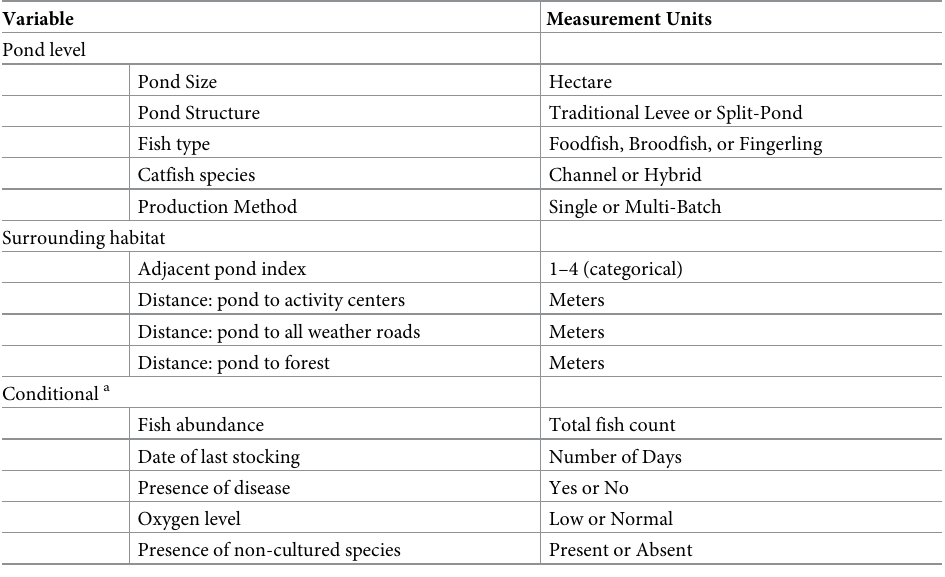
Table 1. Variables of catfish ponds used in occupancy analysis and resource selection functions modeled against the presence of double-crested cormorants, great blue herons, and great egrets on ponds in the Mississippi Delta. Presence data was collected by flying 35 surveys over three consecutive winter seasons (Oct–Apr),